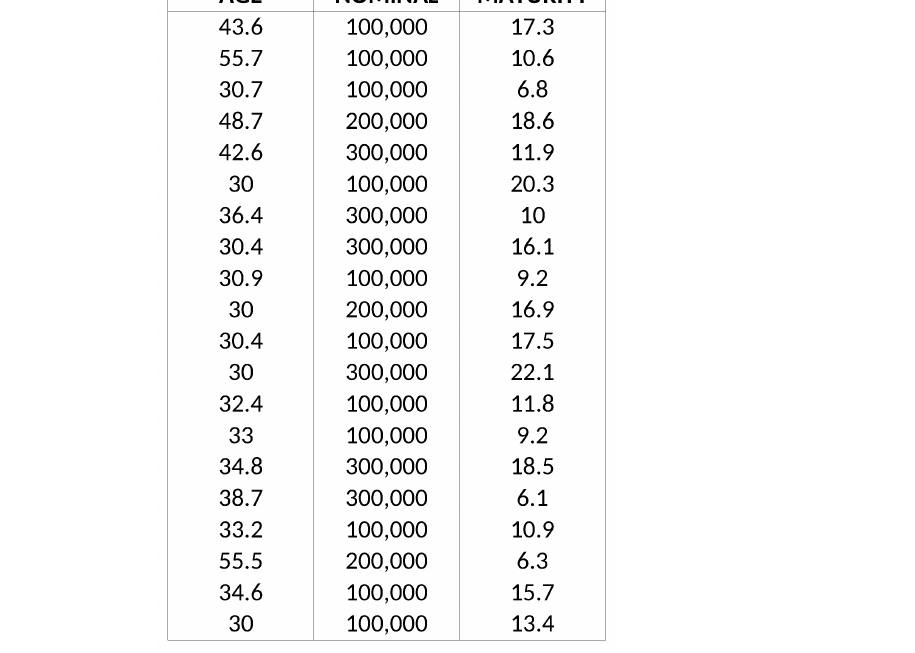
Figure 5. Main data of the first 20 policies out of 10,000 in the portfolio of Example 3.